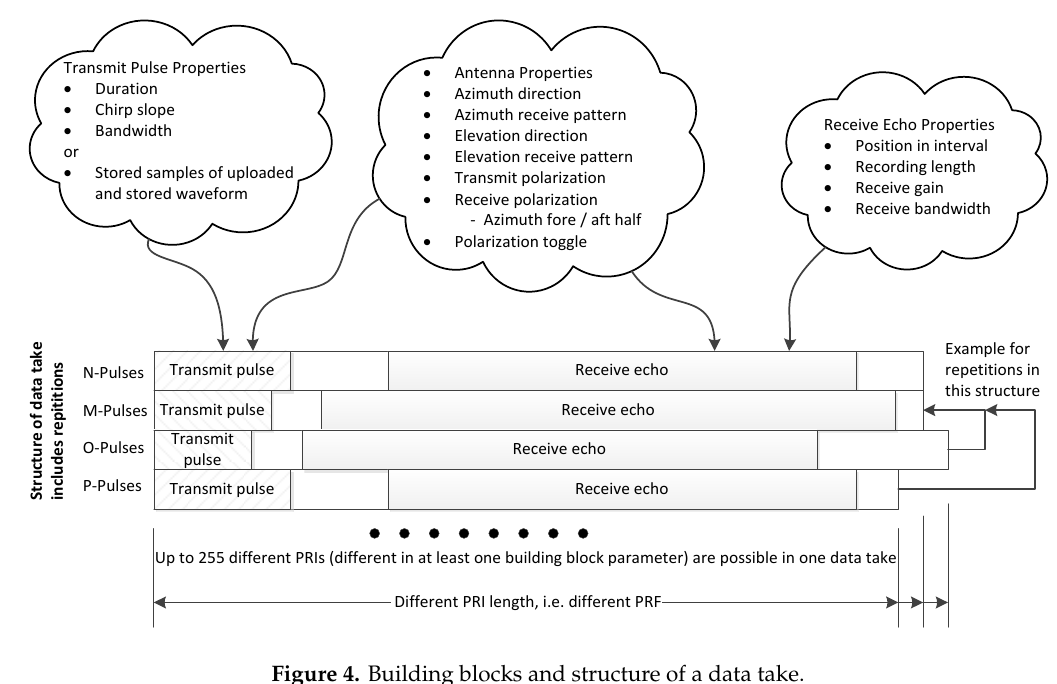
Figure 4. Building blocks and structure of a data take.